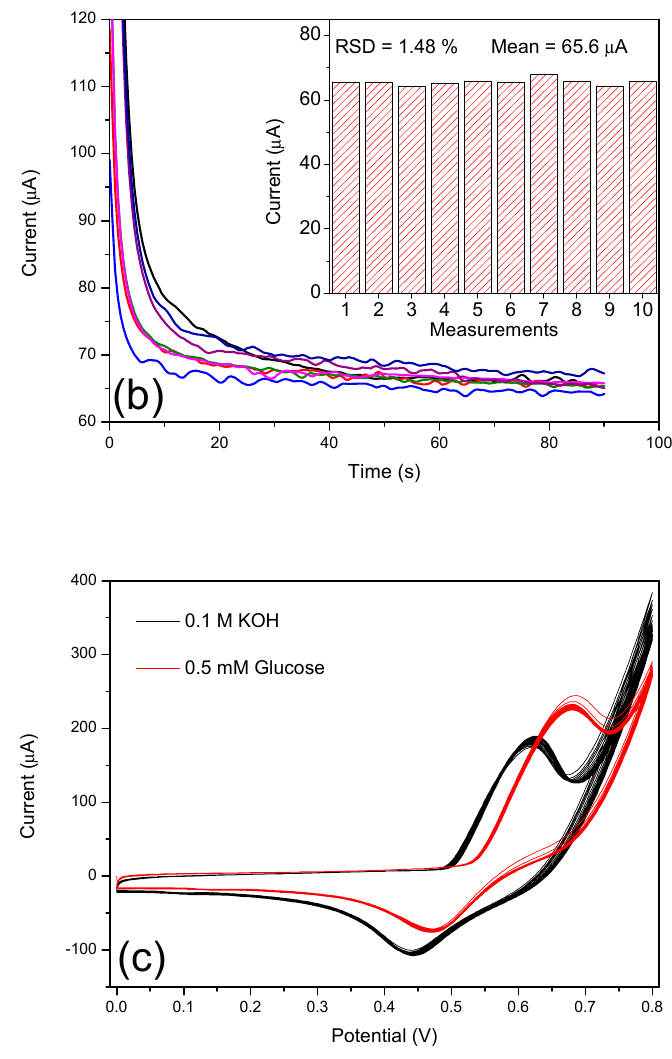
Figure 7. ( a ) Chronoamperometric response of 20 µL N-CS/SPCE in 0.1 M KOH at 0.6 V after successive additions of glucose and interfering molecules. ( b ) Reproducibility of response to 1 mM glucose in 0.1 M KOH. ( c ) Thirty cycles of CV in the absence and presence of 0.5 mM glucose in 0.1 mM KOH.